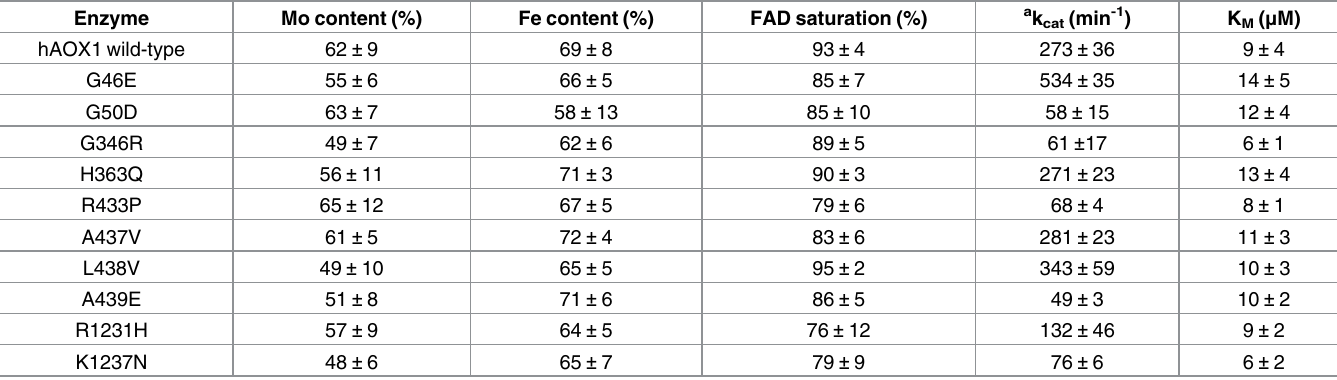
Table 1. Steady state kinetic parameters of hAOX1 wild-type and variants and data for saturation with molybdenum, iron and FAD.